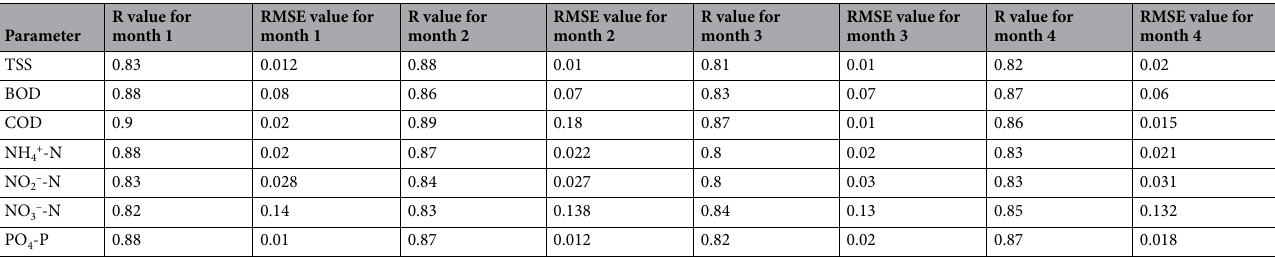
Table 8. R and RMSE values after adjustment for calibration and validation.